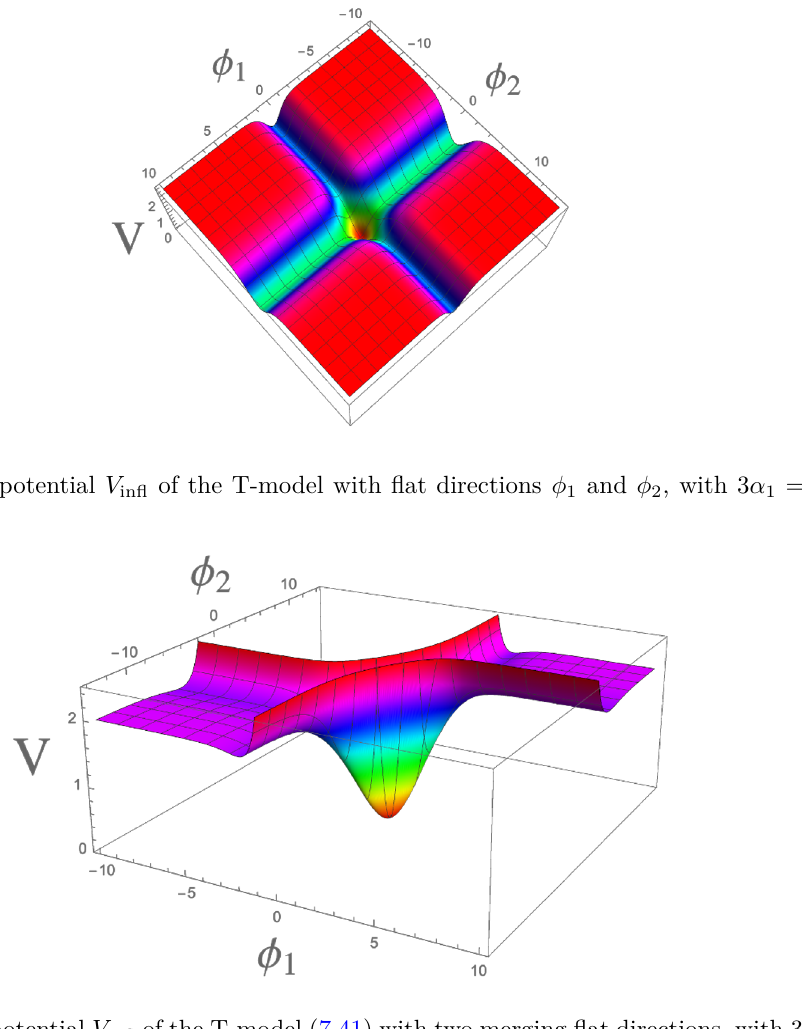
Figure 16 . The potential V infl of the T-model (7.41) with two merging flat directions, with 3 α 1 = 1 and 3 α 2 = 6 and µ = 3 m , in terms of the canonical variables φ 1 and φ 2